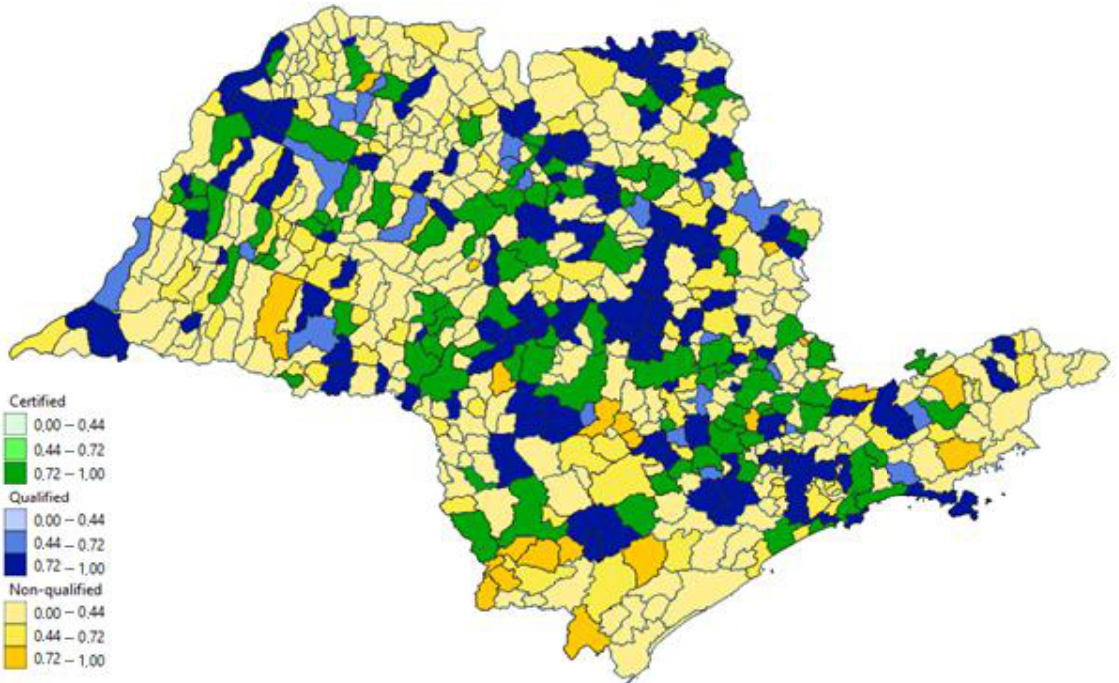
Figure 7. Sustainable Human Development Index.